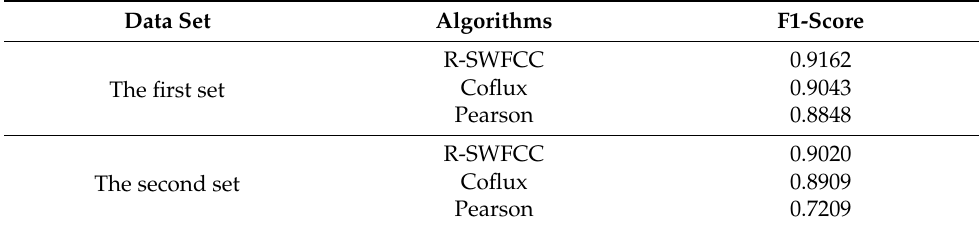
Table 9. The best F1-scores of three algorithms for two sets of data.